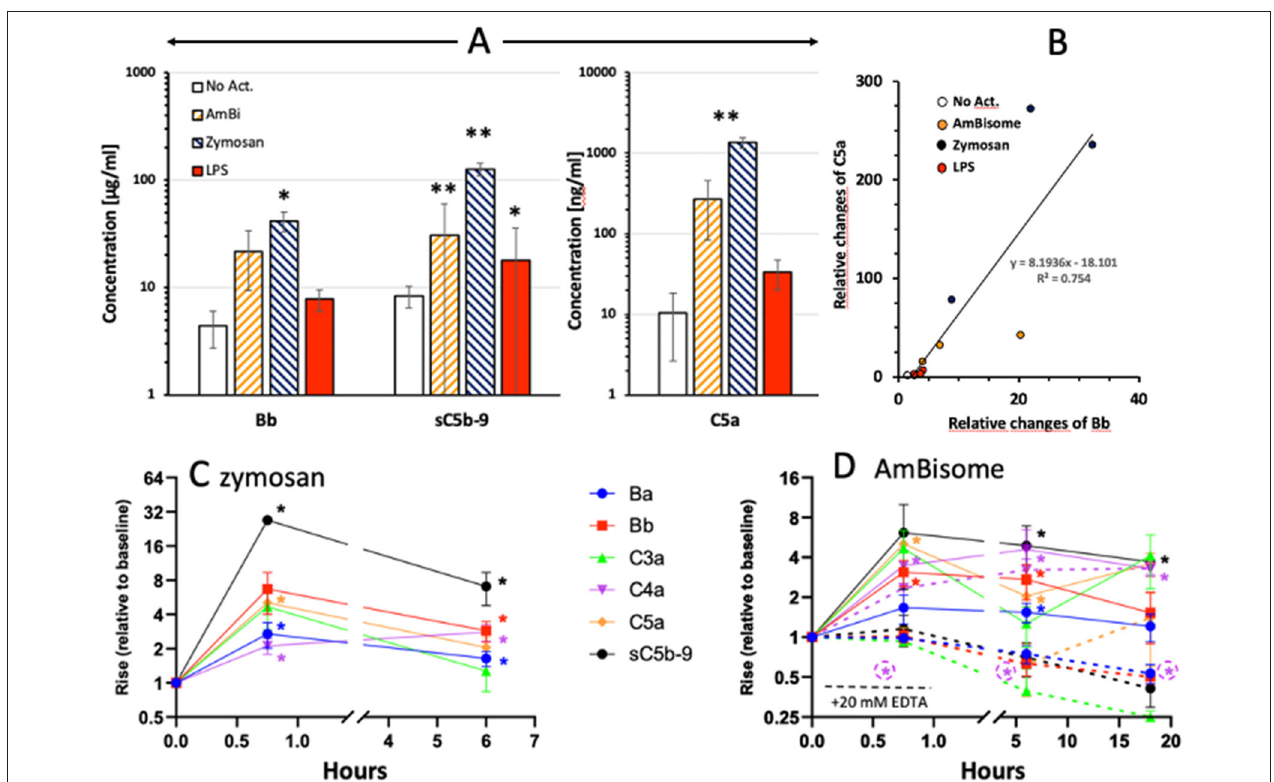
FIGURE 1 | Complement activation by liposomal Amphotericin B (AmBi, 1.98mg PL/ml), Zymosan (0.5 mg/ml) and LPS (0.5 µ g/ml) in PBMC cultures supplemented with autologous serum. (A) Columns and error bars represent mean ± SD ( n = 3); * and ** indicate statistically significant differences comparing to appropriate control (No Act. or baseline) groups, P < 0.05 or 0.01, respectively. (B) Correlation between the individual relative rises (related to 0min) of C5a and Bb in the samples plotted in (A) . Different groups of treatments are represented by different colors (empty: no activation, yellow: AmBisome, blue: Zymosan, red: LPS). Slope shows significant correlation ( P = 0.0002). (C) and (D) , Similar experiments as in (A) , except that the complement activation byproducts were measured by a chemiluminescence